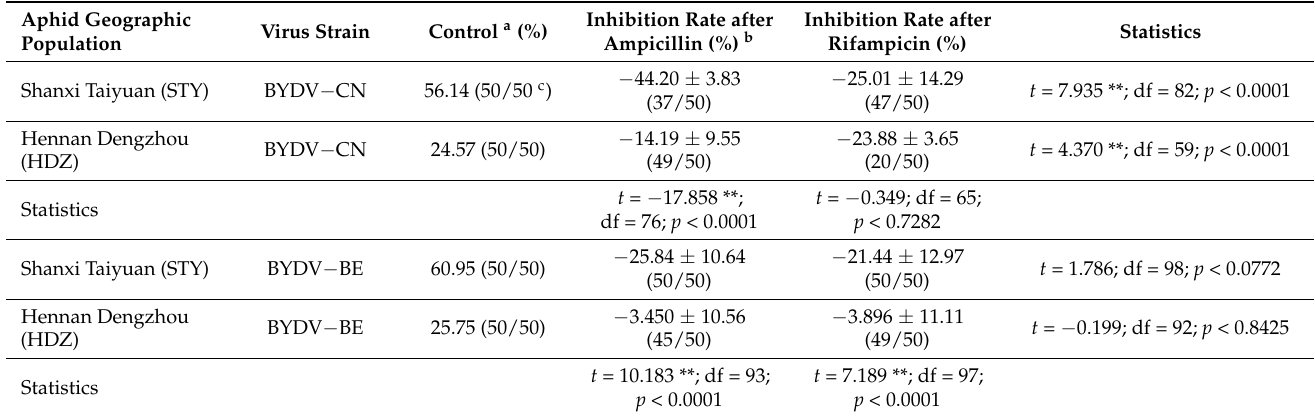
Table 1. Effect of antibiotic treatments on barley yellow dwarf virus (BYDV) transmission rates by two Sitobion miscanthi geographic populations.